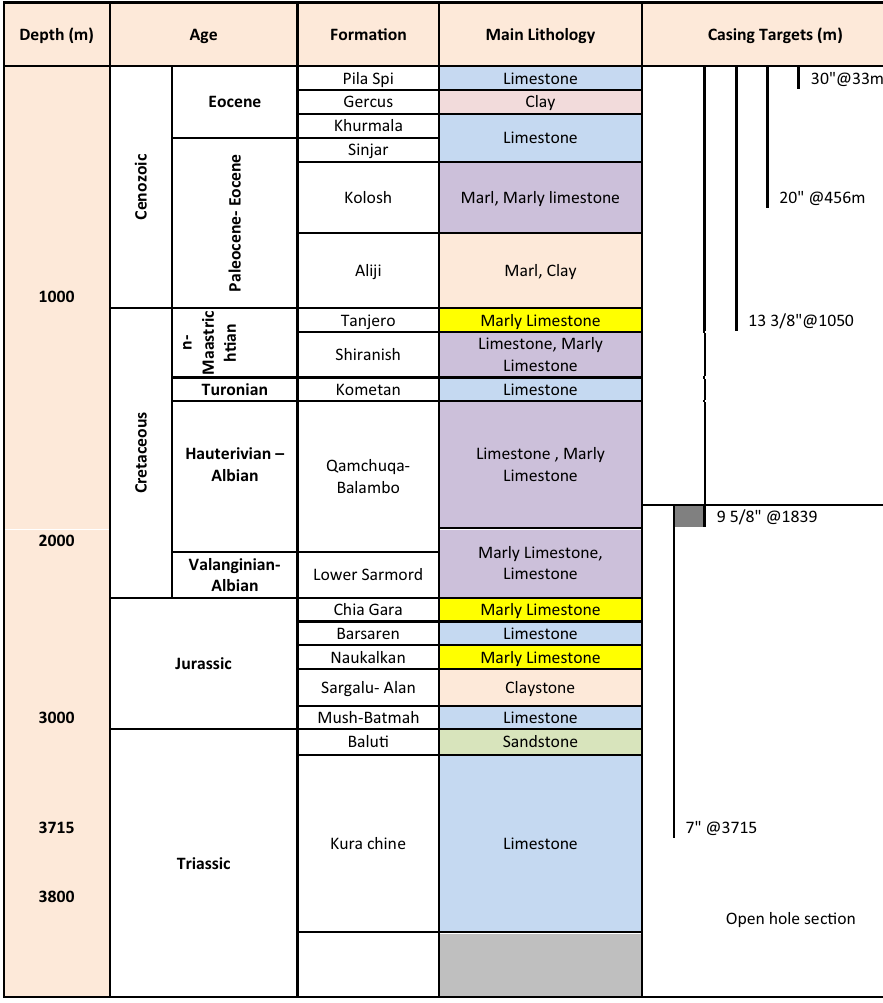
Effect of bottom hole pressure differential Coefficient a 4 in Eq. 7 represents the effect of pressure dif- ferential on ROP. The penetration rate will reduce with the decrease in the bottom hole pressure difference. Whenever the pressure differential between mud hydrostatic pressure and the formation pressure is zero, this effect will be equal to 1 (Bourgoyne and Young 1974).